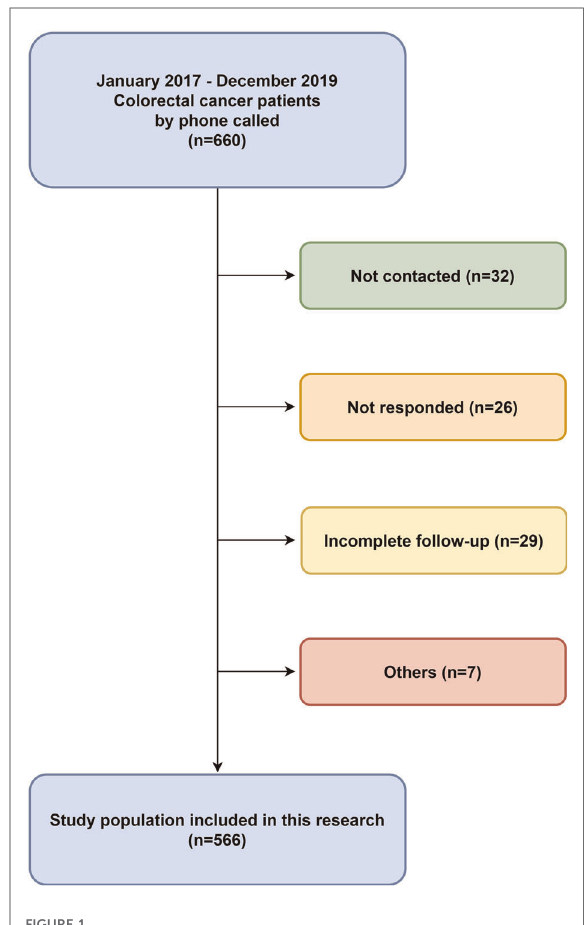
FIGURE 1 Patients collection diagram. This was a retrospective,